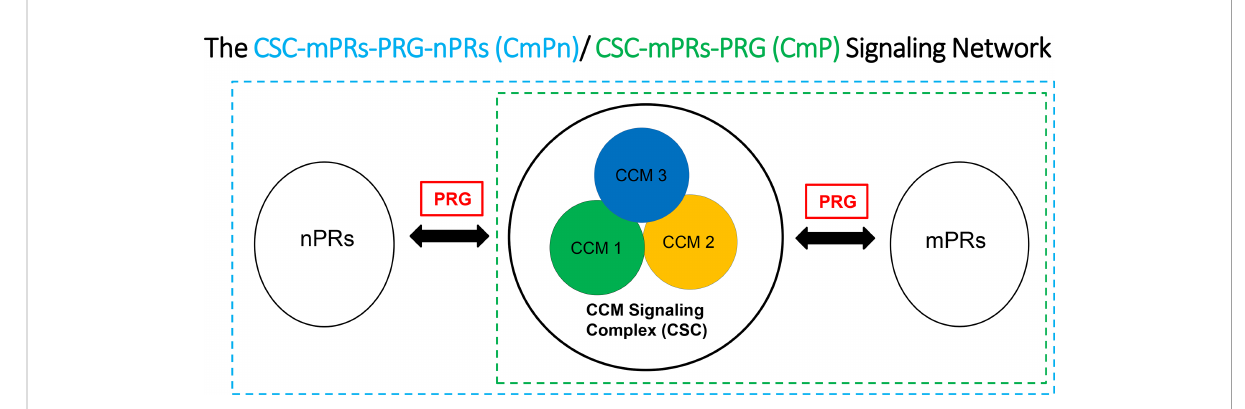
FIGURE 1 Signaling network for key CSC players and the effects of progesterone (PRG) on nPR and mPR. We suggest that the CSC functions as a channel modulator for the interactions of PRG between nPRs and